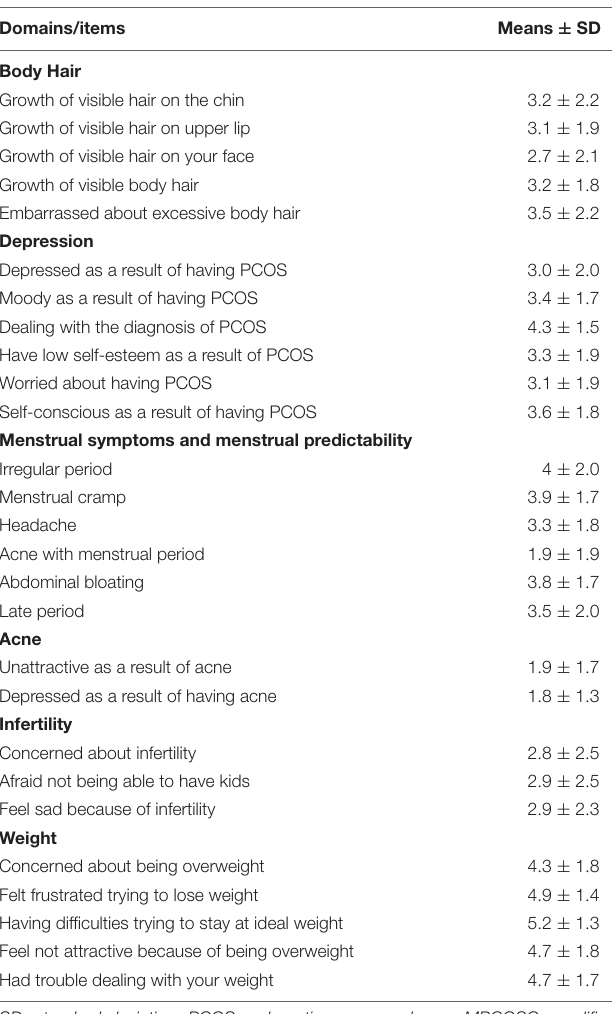
TABLE 2 | The overall Mean scores of six domains of the